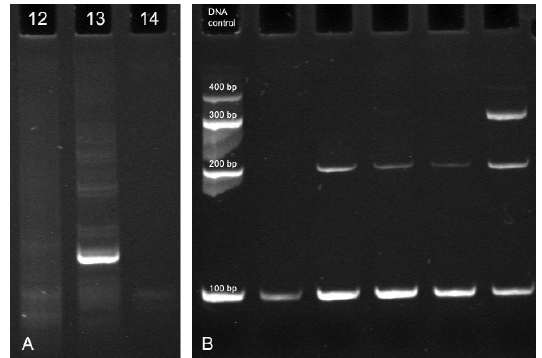
Figure 1A - Clonality analysis of a polyacrylamide gel following electro- phoresis of PCR products using the IgL -K protocol. (12) Polyclonality (broad band, similar to a smear), (13) Monoclonality (well-defined, dominant band) and (14) Not defined (absence of bands or bands without definition) Figure 1B - DNA control: amplification of housekeeping gene fragments of 100, 200, 300 and 400 bp; lane 1: case 1 presenting a band of 100 bp; lanes 2, 3 and 4: cases 2, 3 and 4, respectively, each presenting bands of 100 and 200 bp; lane 5: case 5 showing 3 bands of 100, 200 and 300 bp